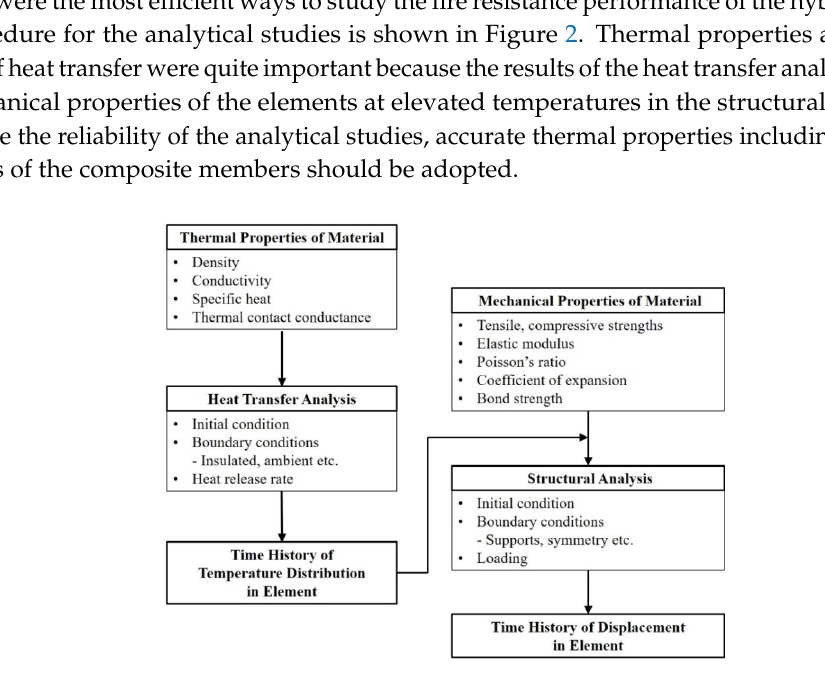
Figure 1. Components of the hybrid floor.